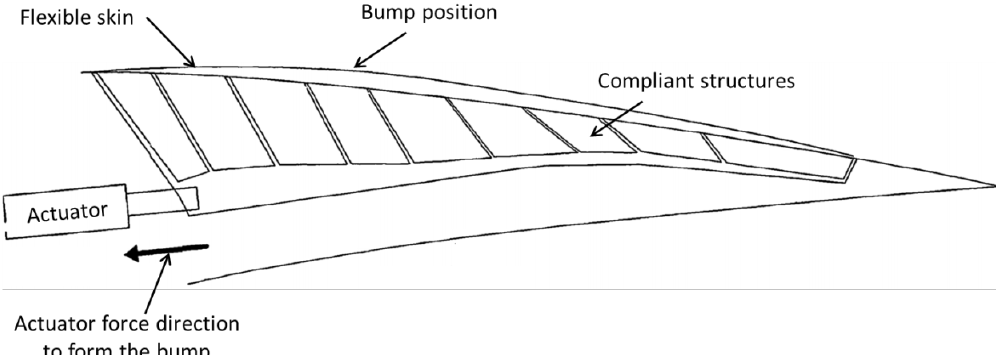
Figure 14. Shock control bump concept with compliant structures based on [88].